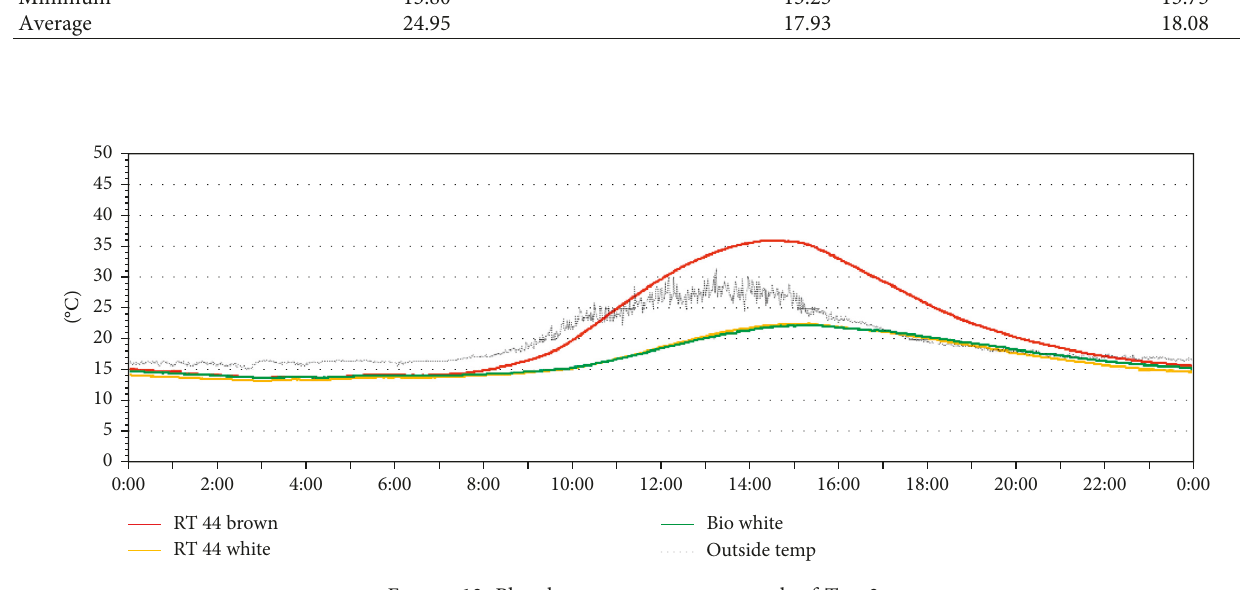
Figure 12: Plate bottom temperature graph of Test 2.